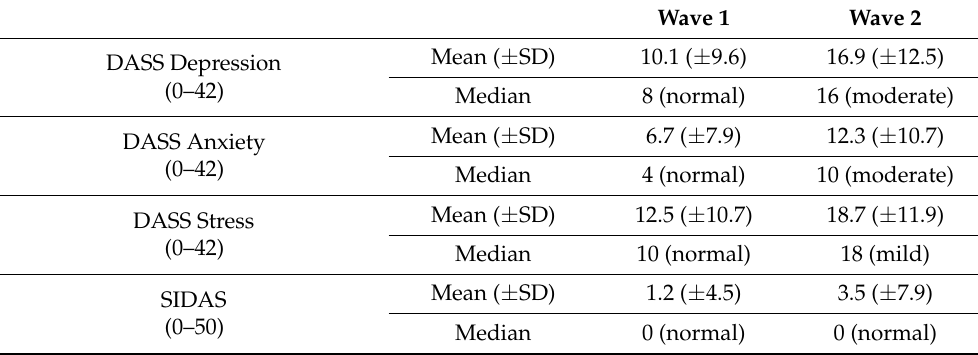
Table 2. Mean ( ± the standard deviation from the mean) and median scores on DASS Depression, DASS Anxiety, DASS Stress, and SIDAS scales in the first and the Omicron wave, in the total